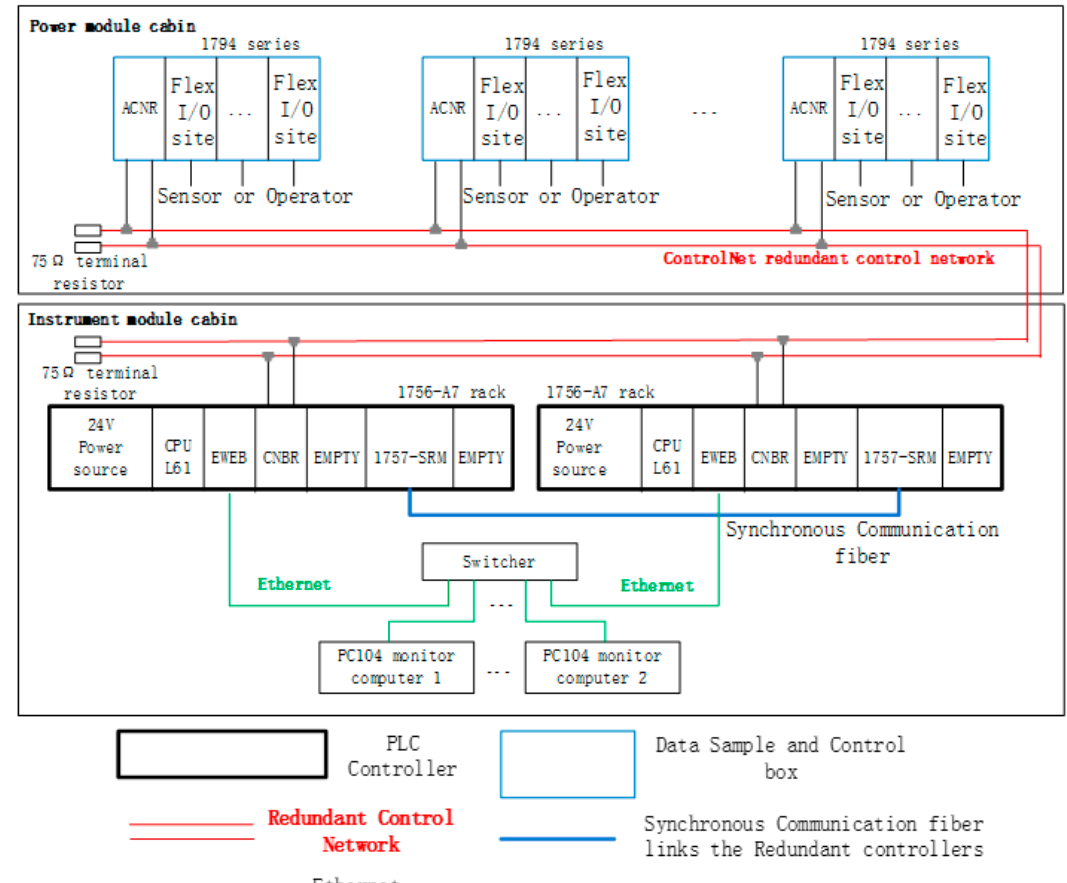
Figure 3. Diesel generator control system hardware structure.